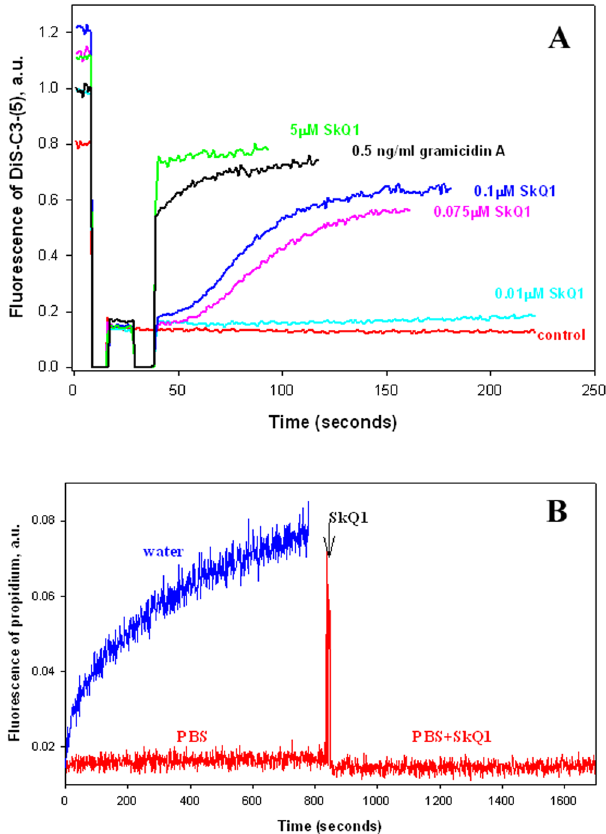
Figure 5. ( A ) Effect of SkQ1 on membrane potential in B. subtilis . Changes in the membrane potential were monitored by measuring fluorescence of DiS-C 3 -(5) (10 µ M) in PBS buffer. Gramicidin A concentration, 0.5 ng/ml. ( B ) Propidium iodide membrane permeability was tested via its fluorescence at 600 nm at 1 µ M. Propidium iodide was present in all samples. Deionized water was used as a positive control of membrane permeabilization. SkQ1 concentration, 1 µ